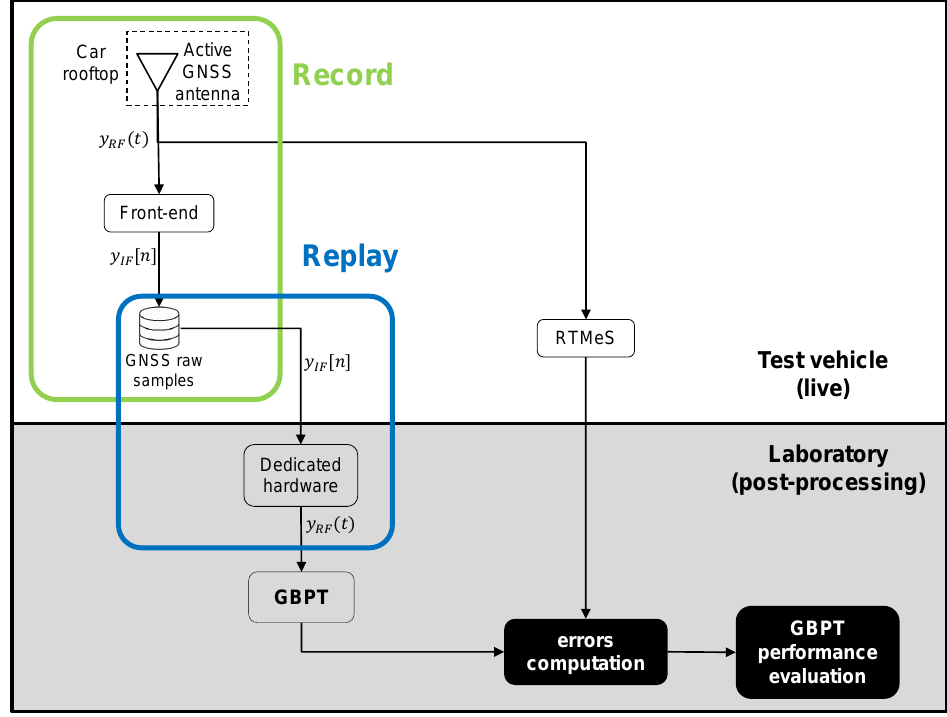
Figure 6. Record and replay system architecture for GBPT performance